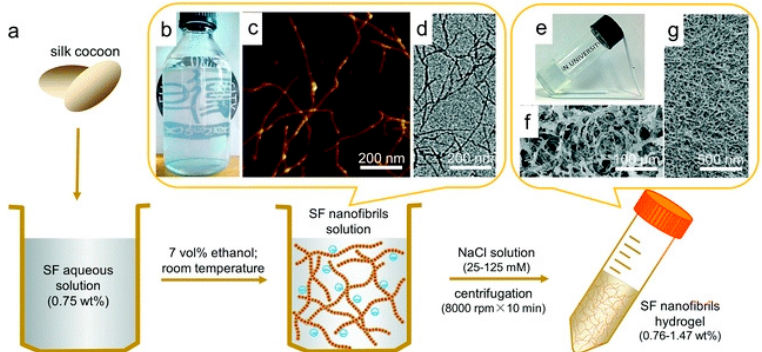
Figure 19. Fabrication of SF nanofibril-based hydrogels with an ECM-like structure. ( a ) Schematic representation of the procedure followed to prepare SF nanofibril-based hydrogels; ( b ) The resultant SF nanofibril solution with opalescence; ( c , d ) AFM and TEM images of SF nanofibrils; ( e ) SF nanofibril-based hydrogel; ( f , g ) SEM images of lyophilized SF nanofibril-based hydrogel with different magnifications, which show an ECM-like structure. Image adapted with permission from reference [80]. Copyright 2016 Elsevier.